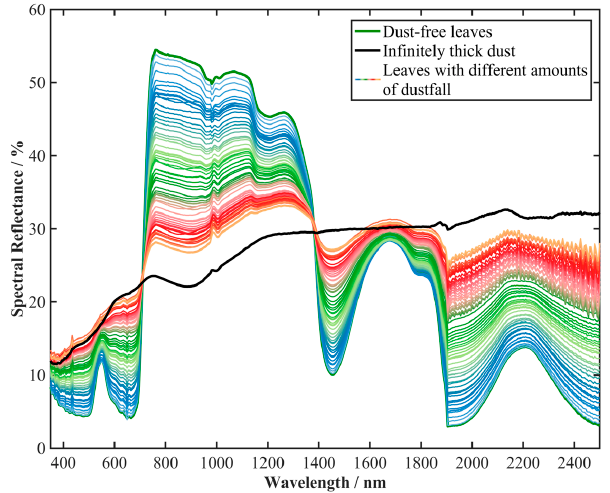
Figure 4. Spectral curves of leaves with different amounts of dustfall.